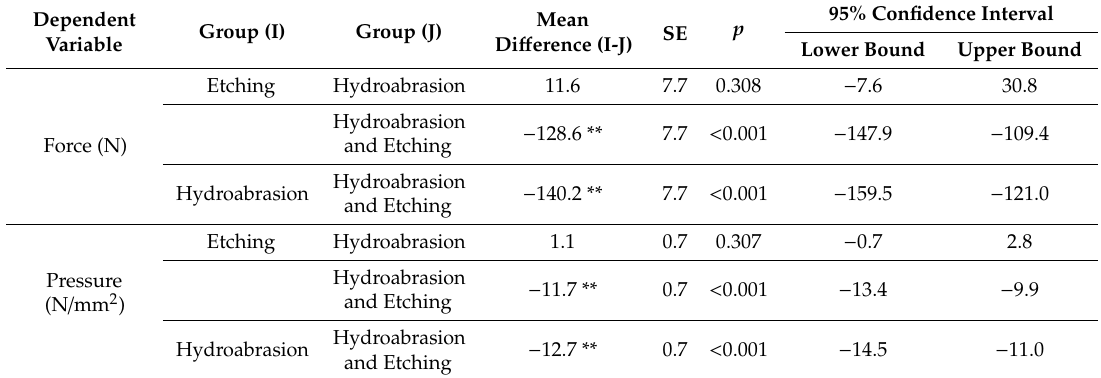
Table 3. Tukey’s post hoc comparison between groups ( n = 10).